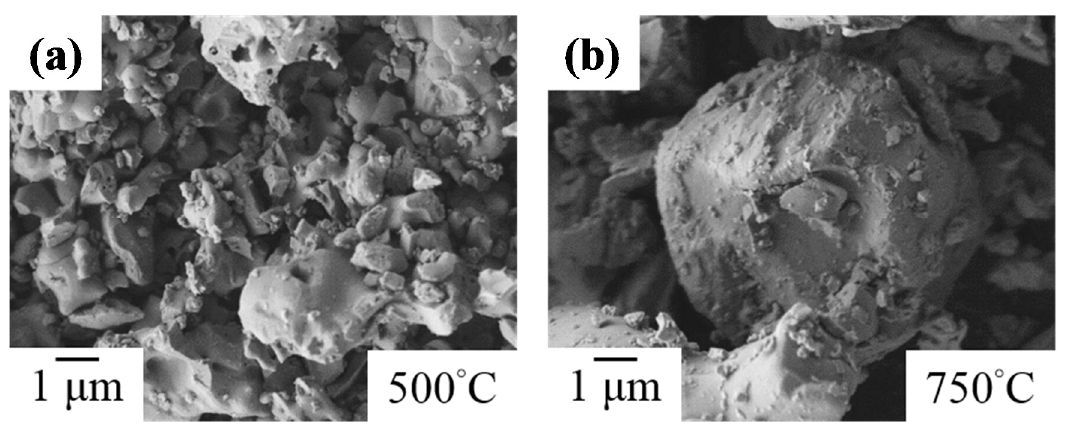
(SAED) in Figure 4c formed diffraction rings, suggesting the existence of nanocrystalline structure. planar spacing of 3.24 and 2.68 Å are consistent with the d values and planes of monoclinic α -Bi 2 O 3 , as shown in Figure 4d,e. In addition, SAED patterns further showed the clear characteristic diffraction patterns formed by crystal planes, revealing a higher crystallinity of products in Figure 4f.